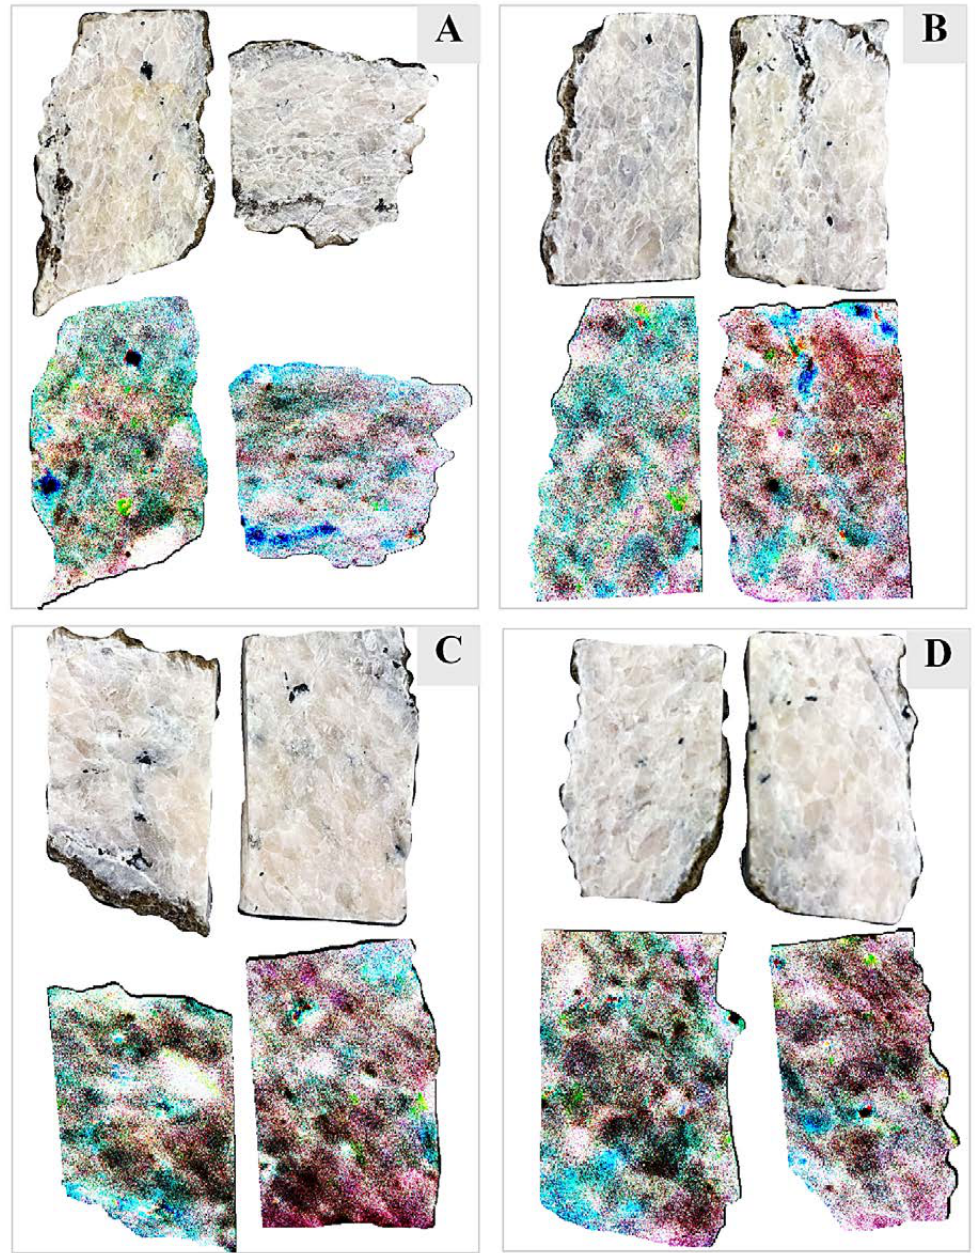
Figure 9. An RGB false-color composite of continuum-removed VNIR bands 69 (587.5 nm), 124 (747.91 nm), and 145 (810.25 nm). The darker the red tone of a pixel, the higher the concentration of Nd in the pixels of ( A ) sample SP1; ( B ) sample SP7; ( C ) sample SP8; ( D ) sample SP9.